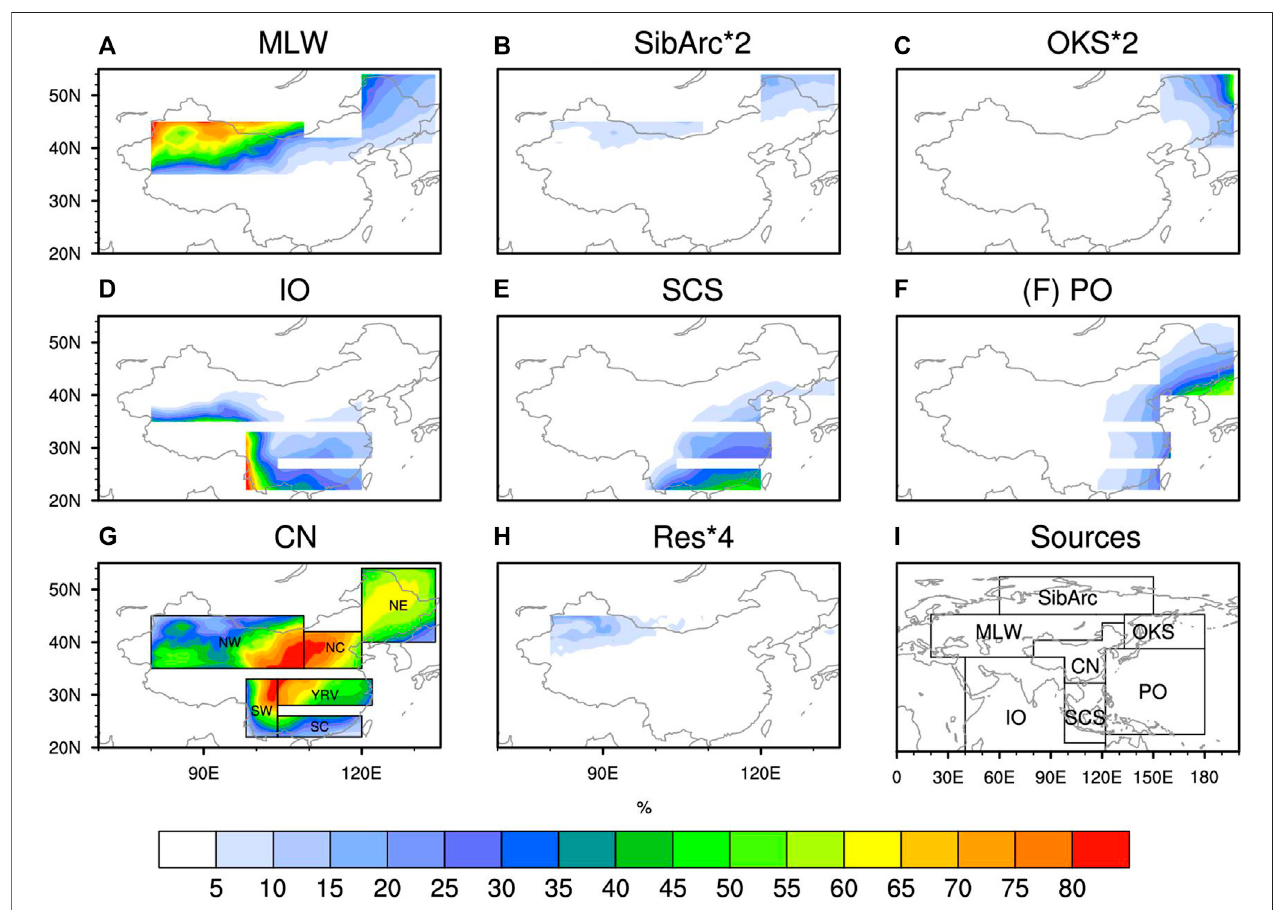
FIGURE 1 | Contribution rates (%) of seven moisture sources to summer precipitation over China: (A) MLW, (B) SibArc, (C) OKS, (D) IO, (E) SCS, (F) PO, (G) CN, and (H) residual. The magnitudes of the SibArc and OKS sources are doubled, and the residual source is quadrupled. The speci fi c geographical division of sources is shown in (I)